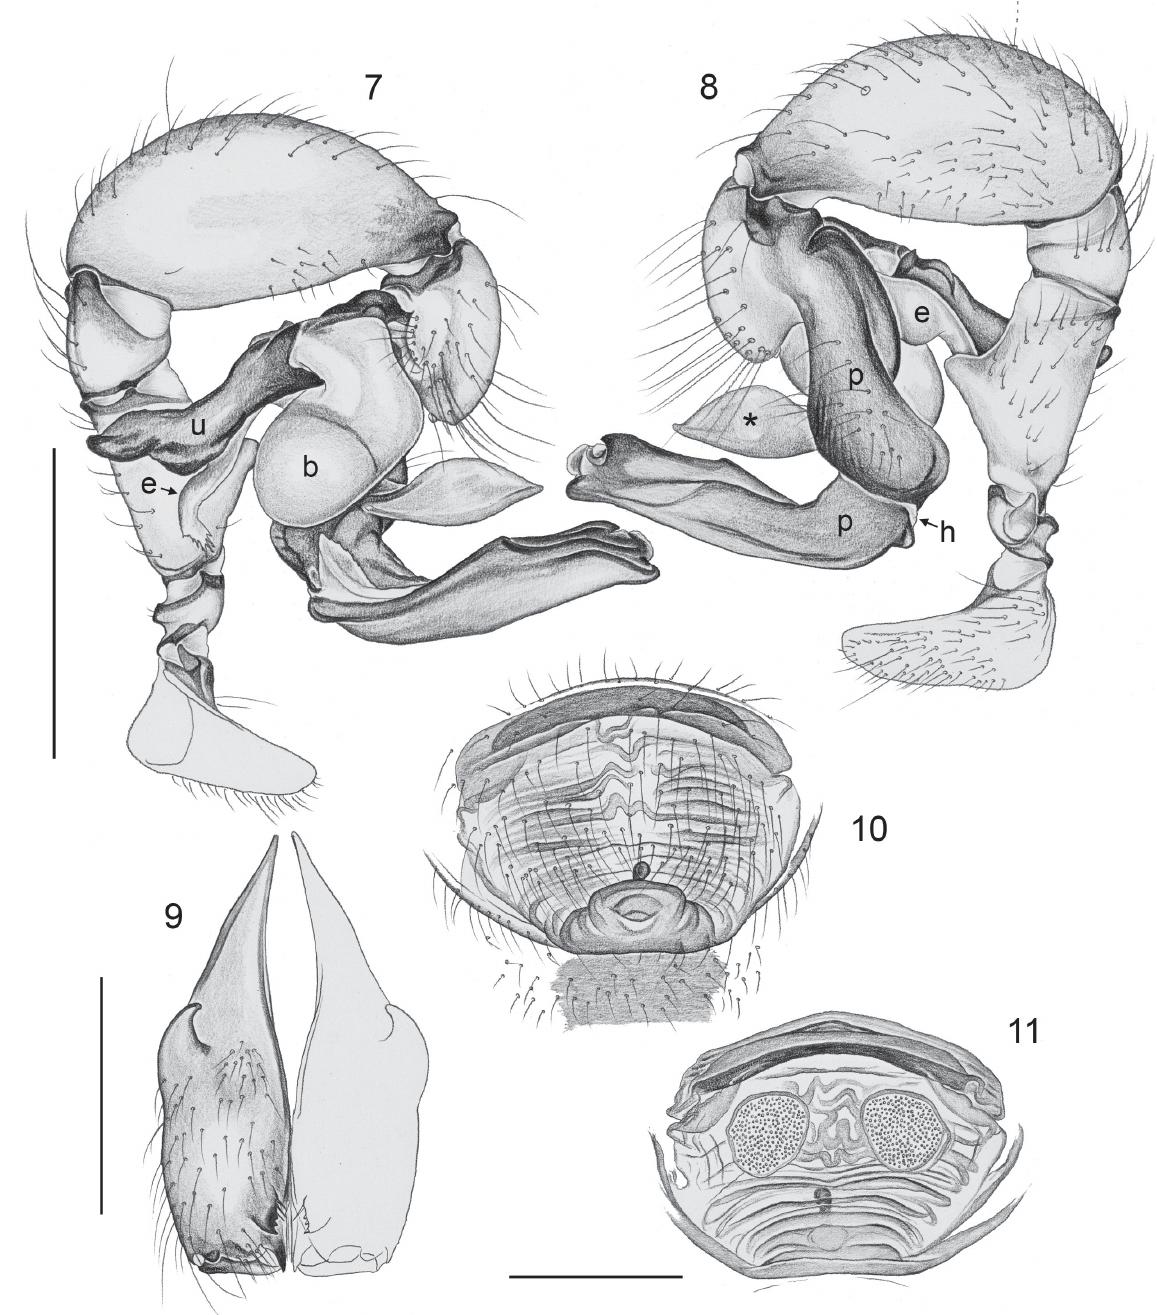
Figs 7–11. Pholcus olangapo Huber, sp. nov., ZFMK Ar 15497–98. 7–8 . Left male palp, prolateral and retrolateral views (asterisk marks prolatero-dorsal process of procursus). 9 . Male chelicerae, frontal view. 10–11 . Cleared female genitalia, ventral and dorsal views. Scale lines: 7–8 = 1 mm; 9–11 = 0.5